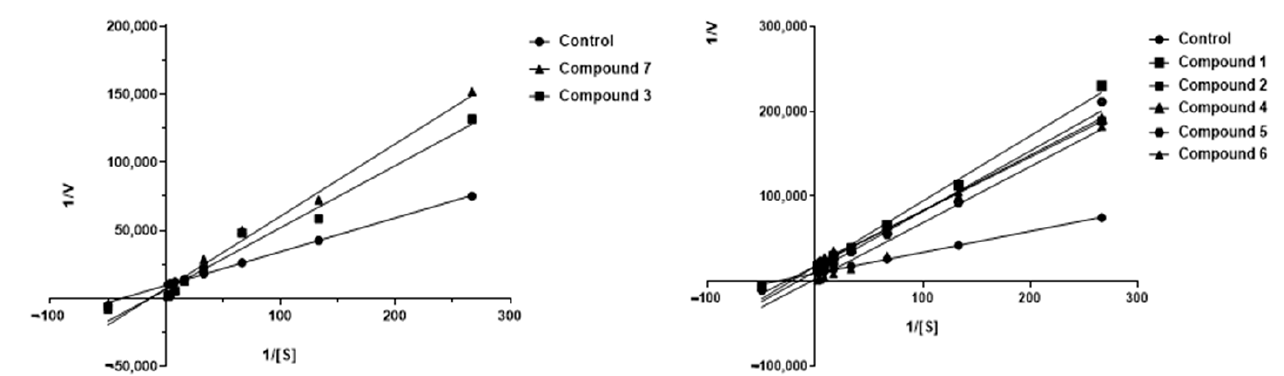
* IC 50 values represent the concentration of the inhibitor required to decrease enzyme activity by 50% and are the mean of the triplicate independent experiments. a: AChE was obtained from human blood samples. Graphical analysis of the Lineweaver–Burk plot gives information about the binding mode. As shown in Figure 4, the lines cross the first quadrant at the same point, and Vmax decreases as the concentration of compound 3 and 7 increases. The Lineweaver–Burk plot reveals that 3 and 7 are partially competitive AChE inhibitors.